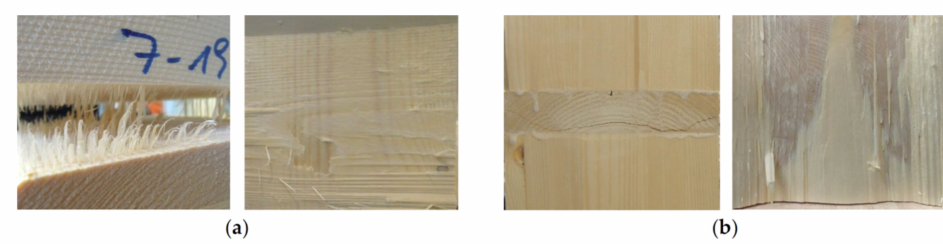
Figure 9. ( a ) intra interface fracture within specimen in adjacent orthogonally laminated board segments; ( b ) W-fracture (intra fracture) within board segment within the specimen.